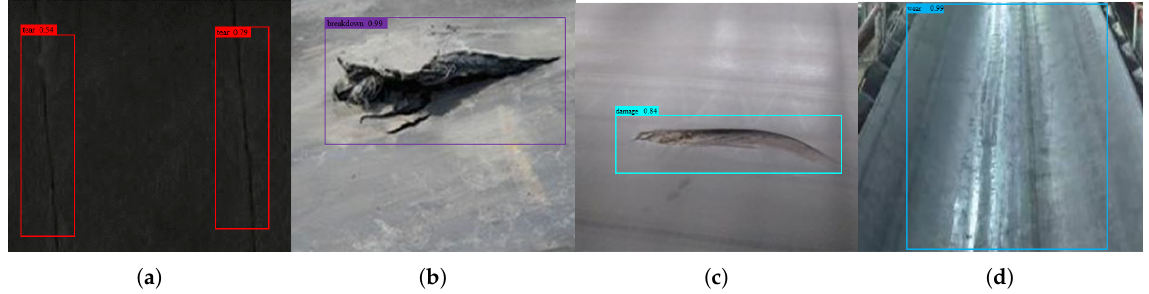
Figure 6. The detection results of the target detection algorithm on the dataset: ( a ) tear, ( b ) breakdown, ( c ) damage, ( d ) surface